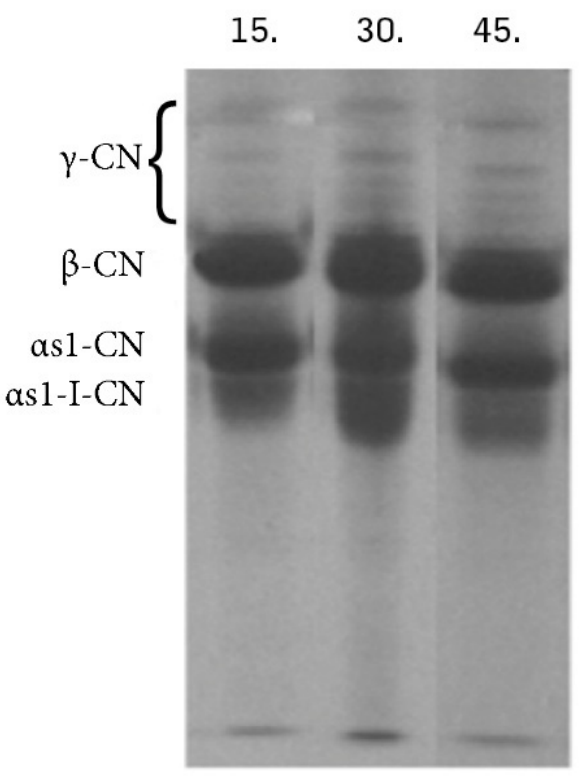
Figure 1. Urea–polyacrylamide gel electrophoresis patterns of control Sir iz mišine (without addition of starter culture) at 15, 30, and 45 days of ripening.